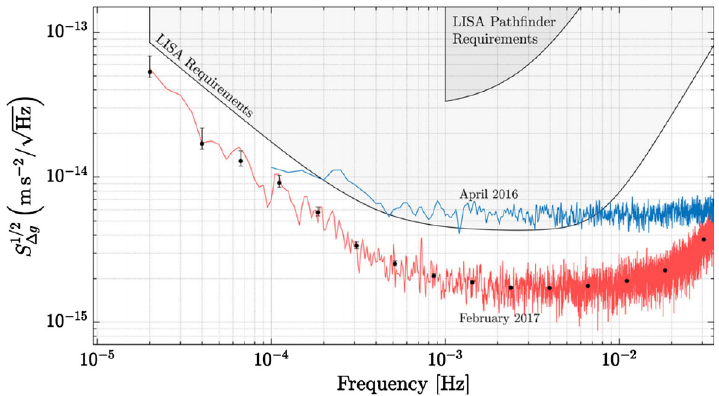
Fig. 5 Amplitude spectral density of LISA Pathfinder as compared to the previous publication of the LPF group (Armano et al. 2016), which is the curve in blue. The data are compare with LISA requirements, as presented in Amaro-Seoane et al. (2017). We can see that LISA Pathfinder exceeds the requirements for key technologies for LISA over a factor of two over the entire observation band. Image reproduced with permission from Armano et al. (2018), copyright by the